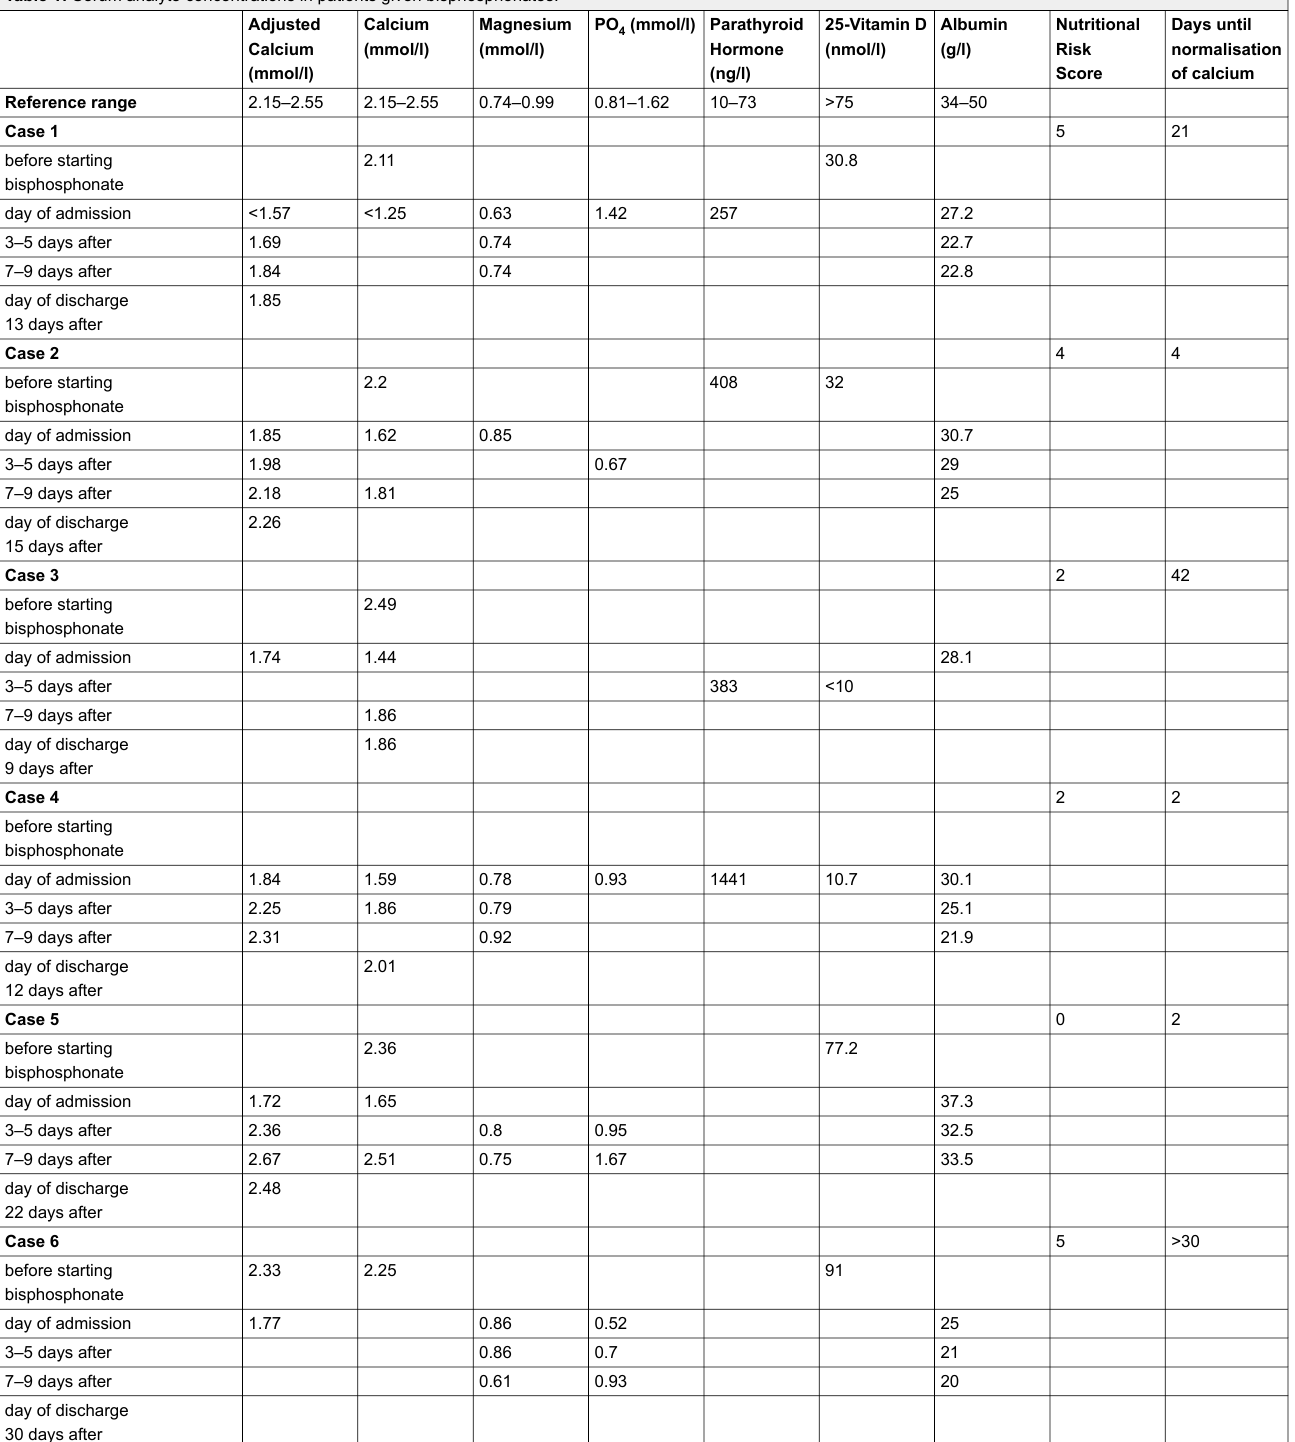
Table 1: Serum analyte concentrations in patients given